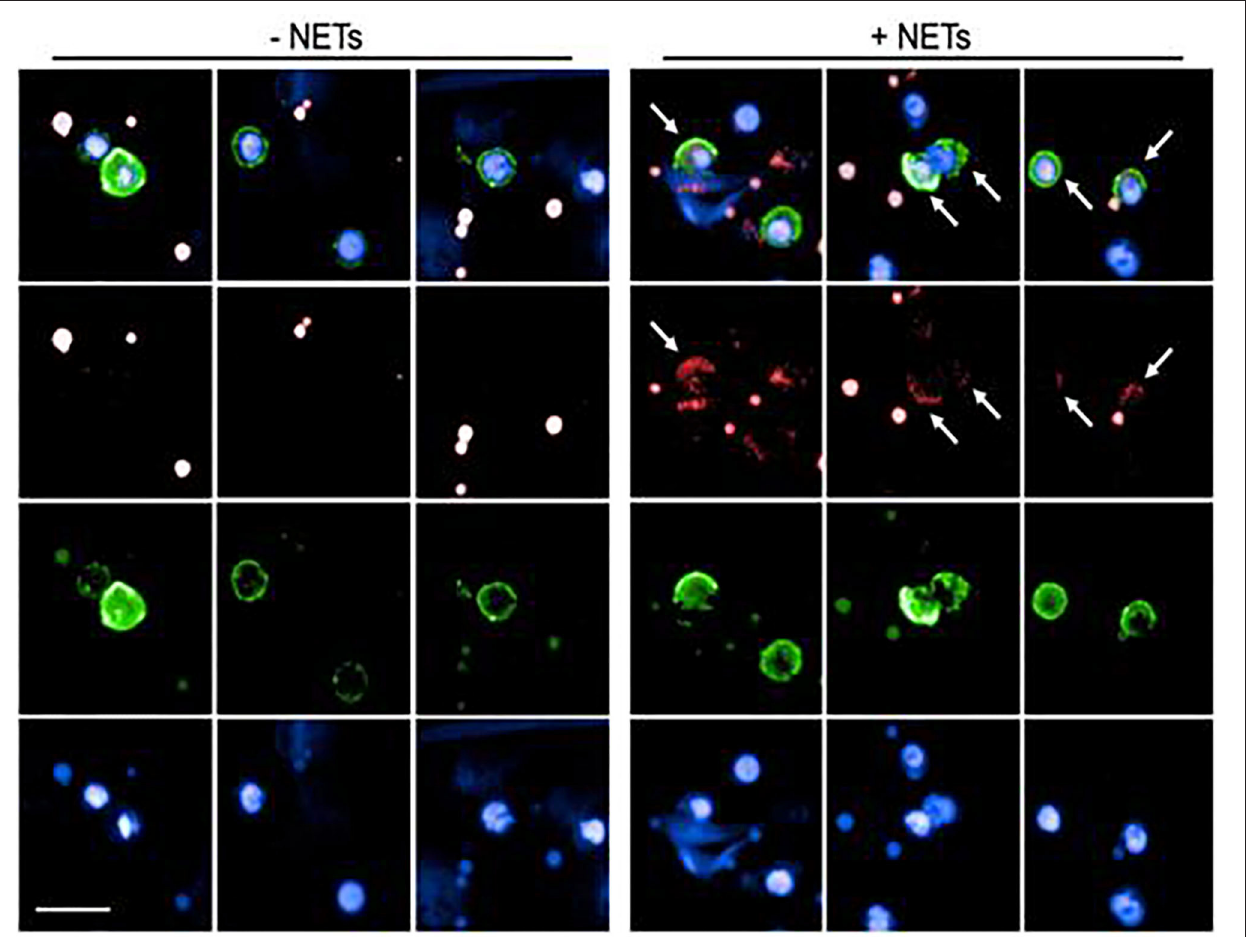
FIGURE 1 | Analysis of NET uptake by B lymphocytes. Representative images of B lymphocytes in the presence (right panel) or absence (left panel) of NET extracts. Surface green staining identifies viable CD20 + B cells. Nuclei were counterstained with Hoechst 33342 (blue staining). NETs were labeled with Alexa 647 conjugated anti-Myeloperoxidase (red staining). Both in the left (untreated cells) and in the right (NET-treated cells) panels, red dots are visible, due to aspecific anti-MPO staining in dead cells. Viable cells, characterized by the integrity of cell membrane (green stain) were analyzed for the presence of small red spots (detectable only in NET-treated cells), indicating specific MPO-staining, and demonstrating the intracellular presence of NET fragments. Arrows indicate the presence of internalized NET